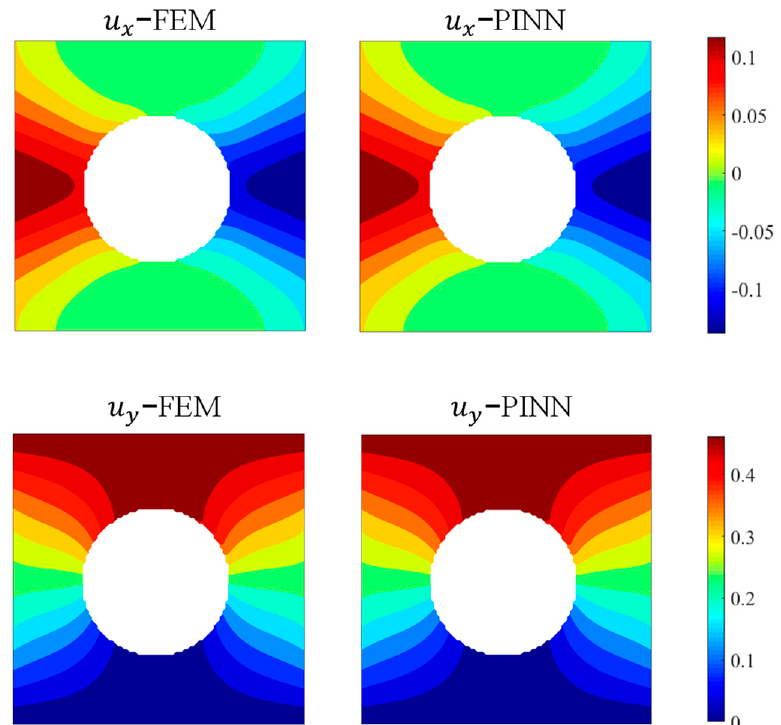
Figure 5. Comparison of the calculated displacement fields ( left : FEM; right : PINN) of the in-plain stretching-related solid mechanics problem.